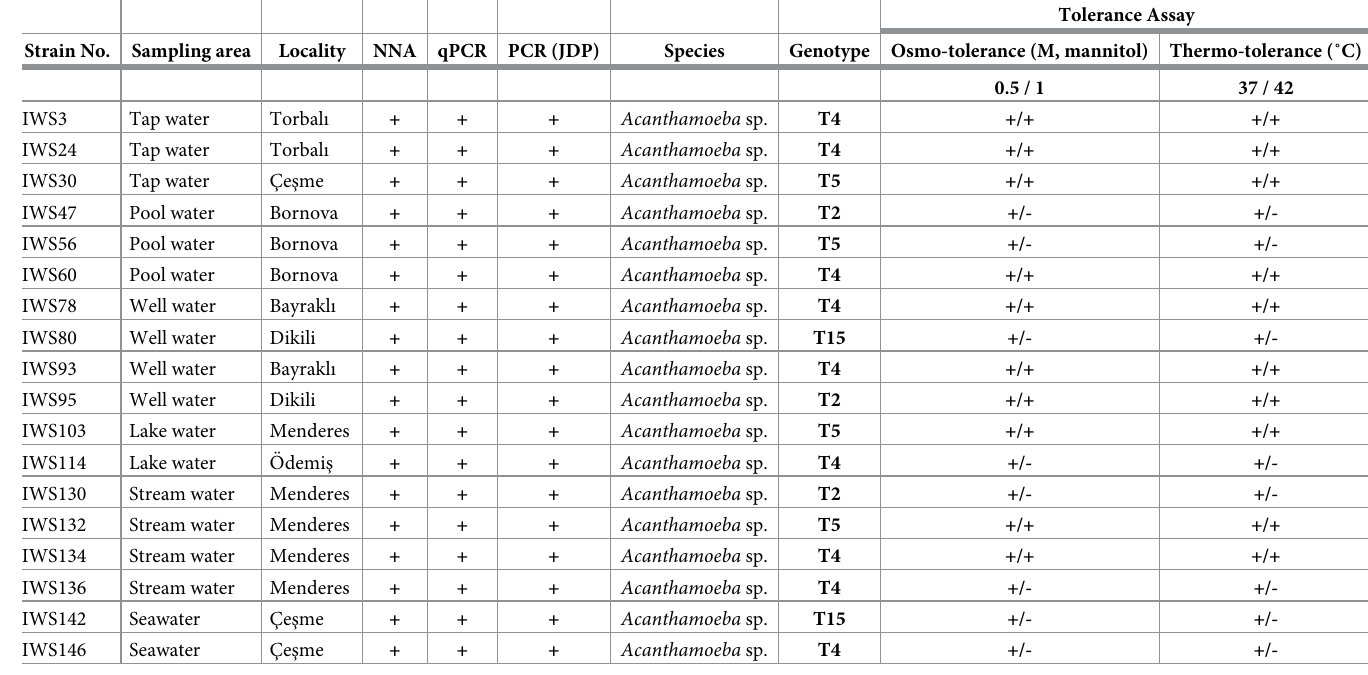
Tolerance Assay